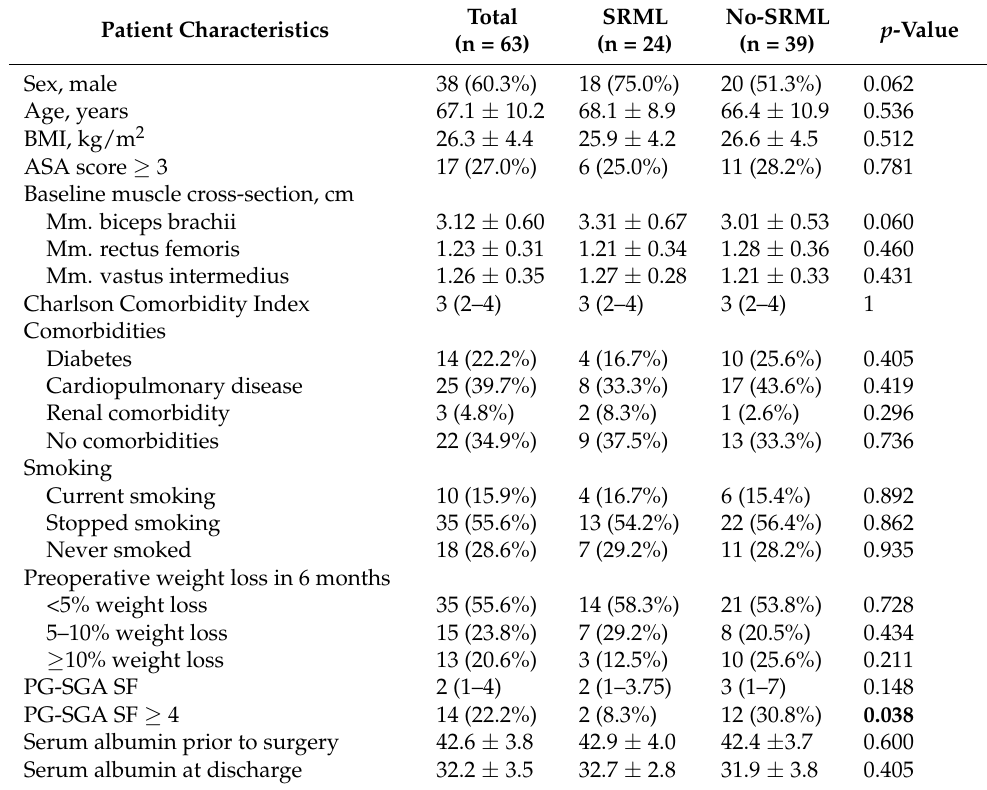
Table 1. Patients characteristics compared between the presence of clinically relevant